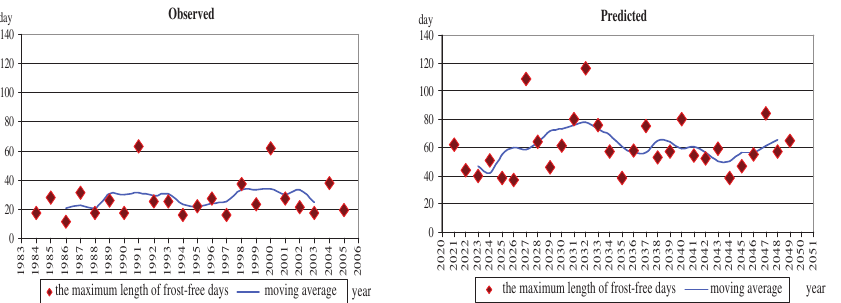
Figure 3. The maximum length of frost-free periods at Újfehértó in the past and according to the model RegCM3.1 during the rest period of sour cherry (early October – end of March)